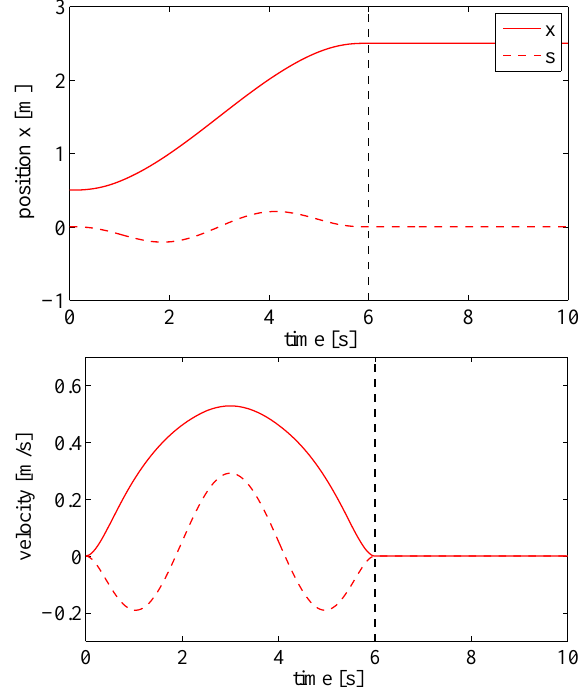
Figure 11. Mass on car – case 4, flat system: computed states , ˙ q q d d